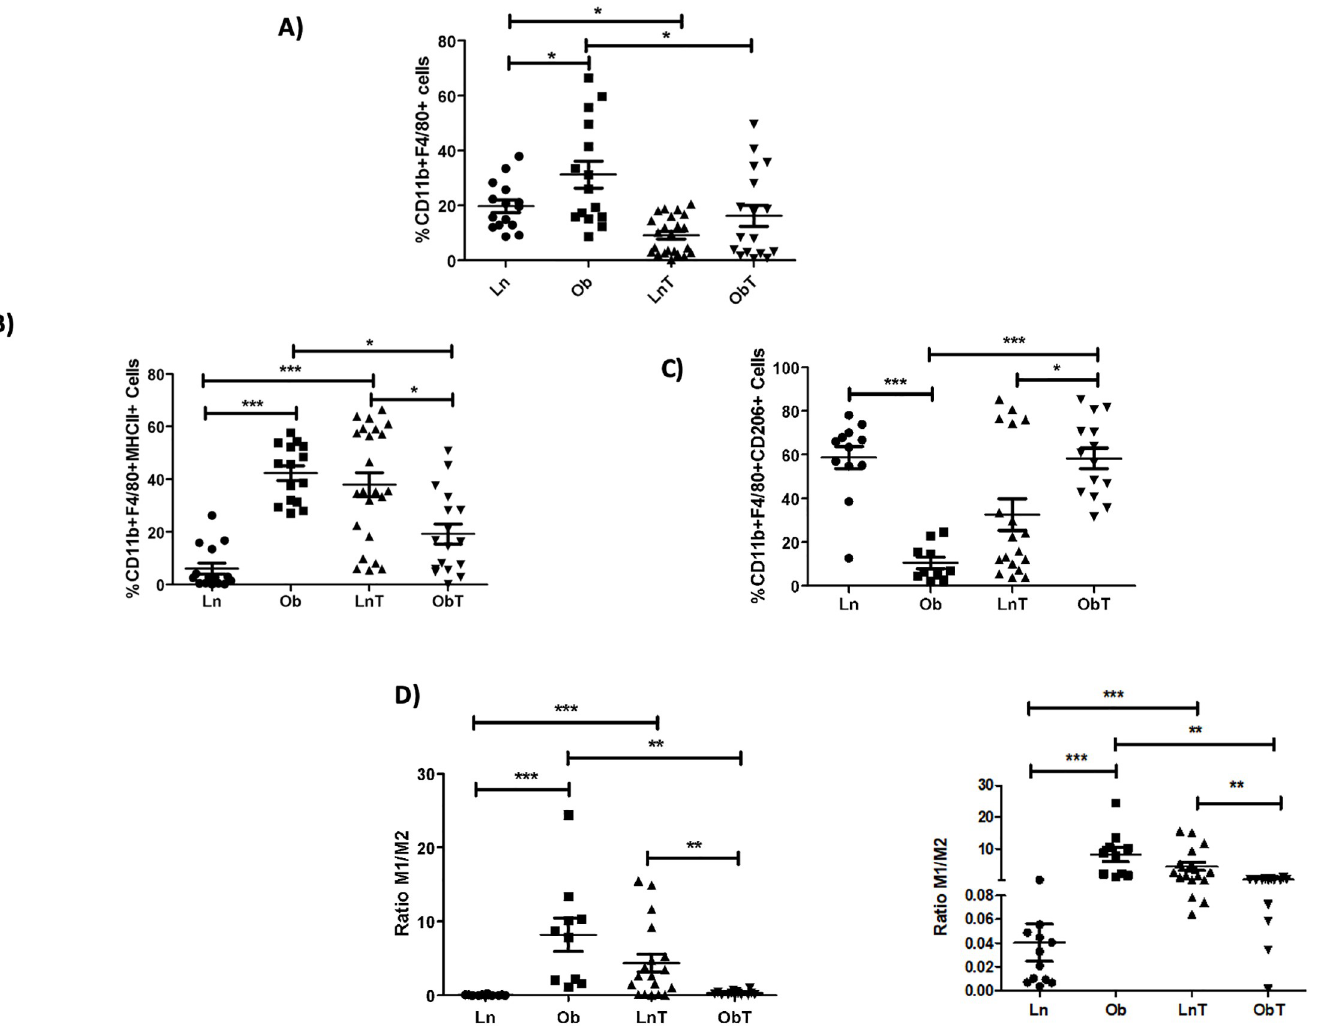
Fig 7. Tumor development alters the percentage and M1/M2 phenotype of VAT macrophages in obese mice. Percentages of A) CD11b + F4/80 + B) MHCII + M1, and C) CD206 + M2 VAT macrophages and D) M1/M2 ratio found in VAT from tumor-bearing or control lean and obese mice. Data are expressed as Mean ± SEM of three to four independent experiments. Statistical significance was determined by one-way ANOVA. � p � 0.05, �� p � 0.01, ��� p �